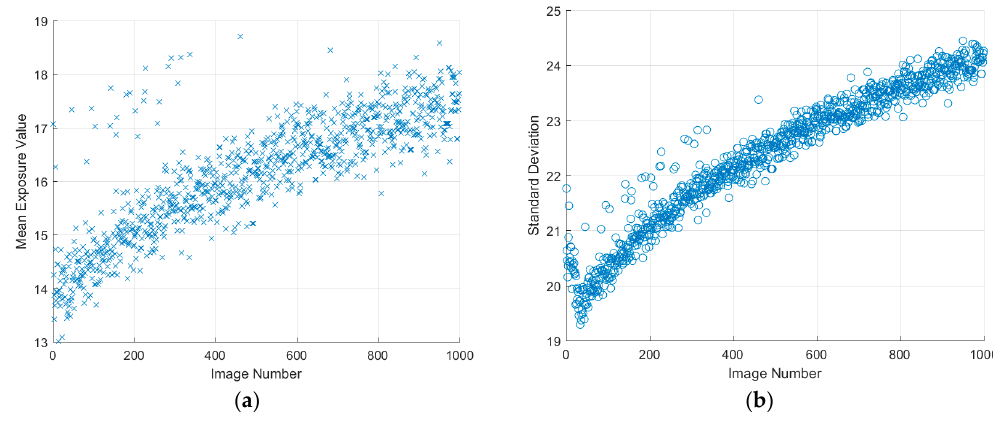
Figure 11. Basler Dart long-time response over 1000 images ( a ) mean image value and ( b ) image standard deviation.